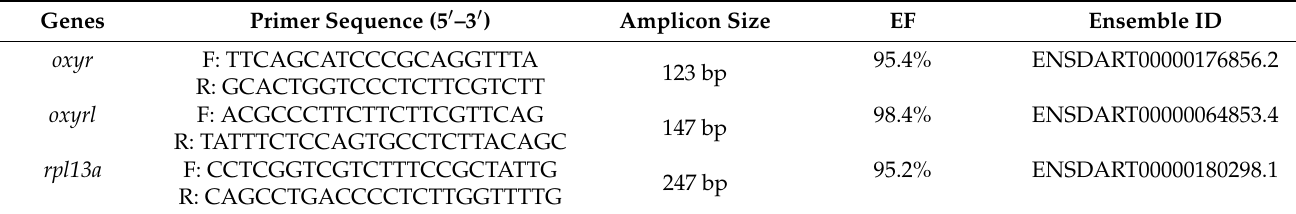
Table 1. The information of primer sets used in the present